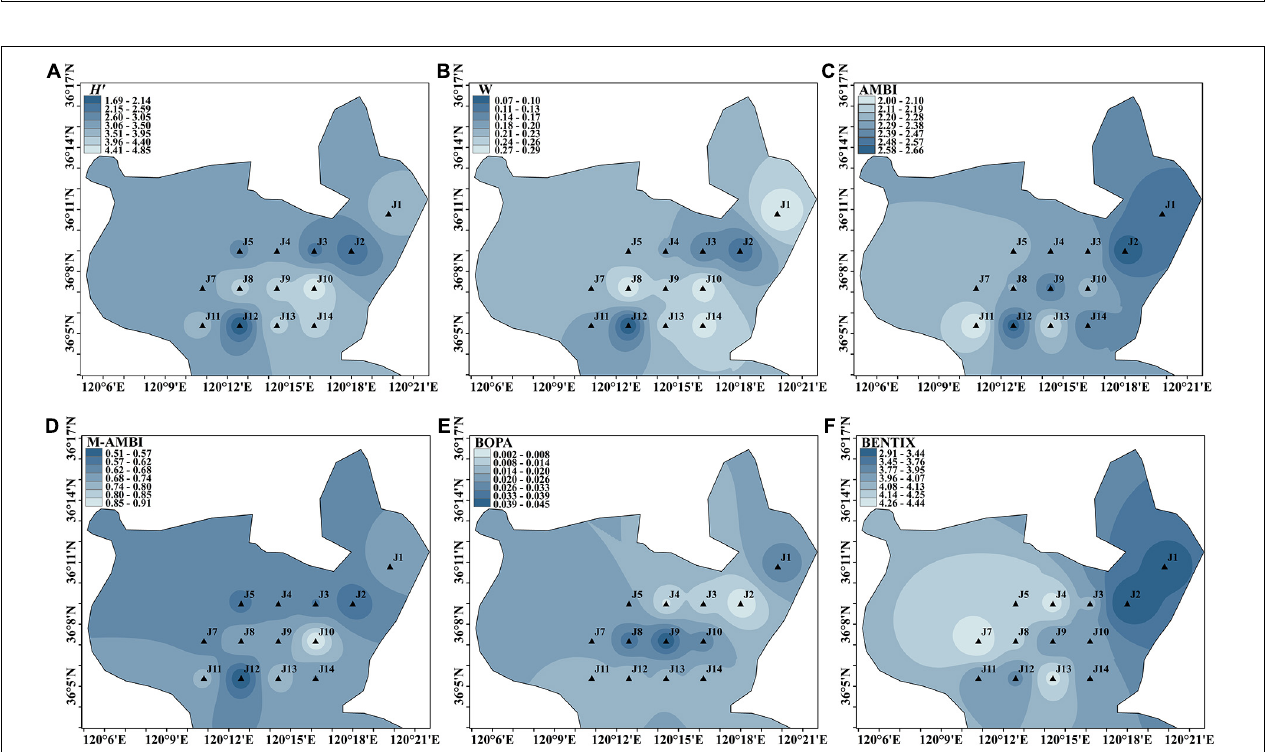
FIGURE 3 | Spatial distribution of environmental assessment in spring cruise in Jiaozhou Bay, H (cid:48) (A) , W (B) , AMBI (C) , M-AMBI (D) , BOPA (E) , and BENTIX (F) .